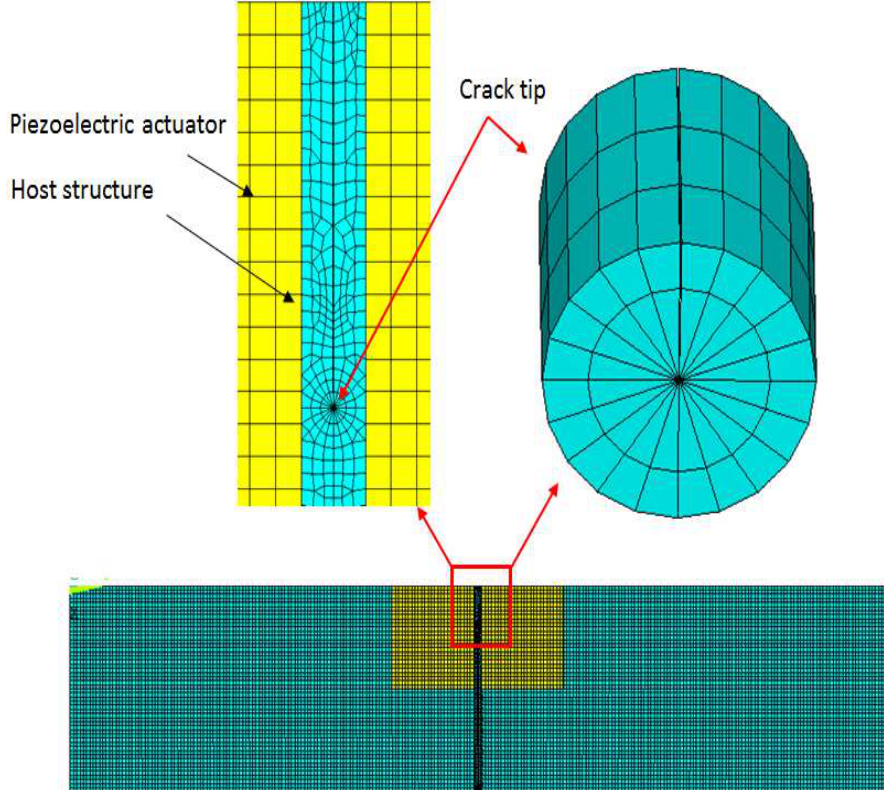
Figure 3. Typical FEM mesh of the repaired plate integrated with piezoelectric actuator and near the crack tip singular element.